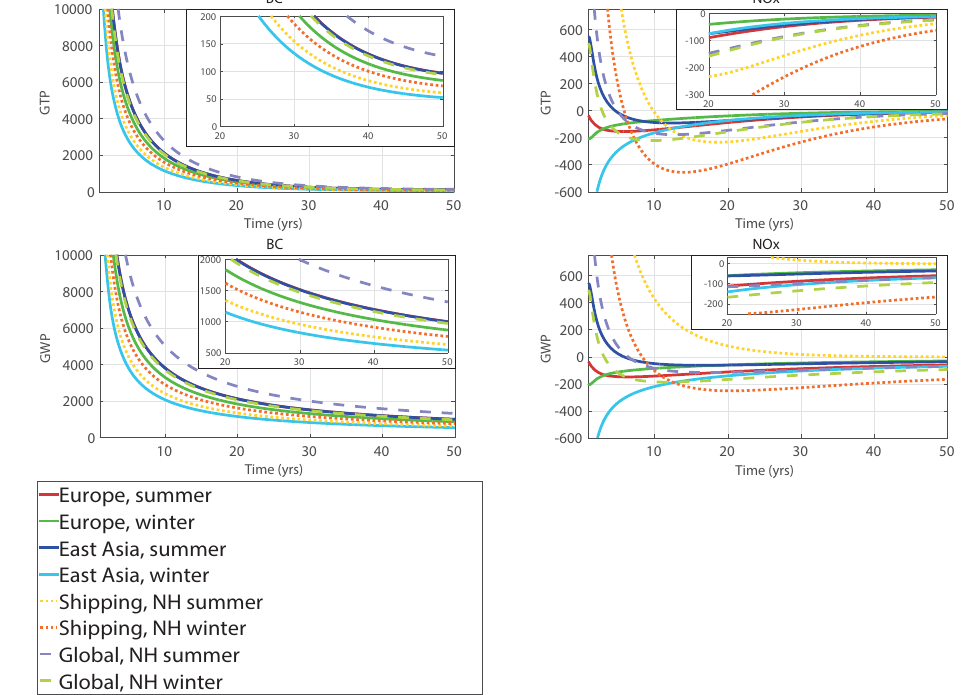
Figure 7. GTPs (top) and GWPs (bottom) for BC (left) and NO x (right) as a function of time horizon, for all emission cases.